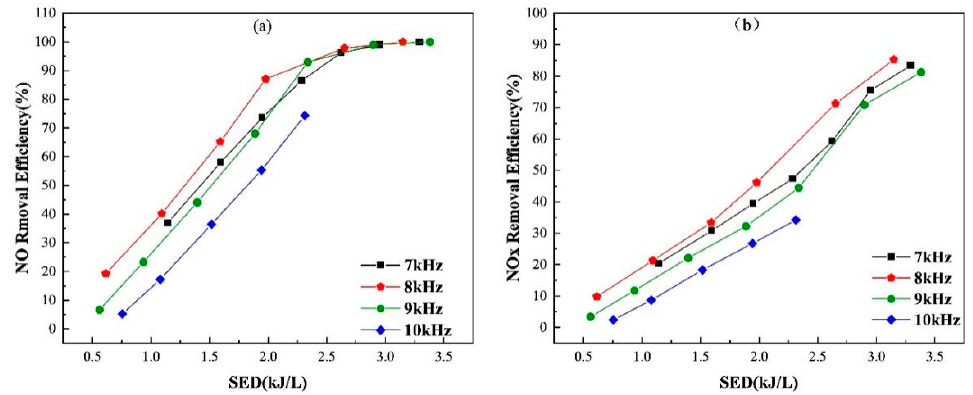
Figure 4. The variation of DBD discharge density with discharge voltage under different discharge frequencies.